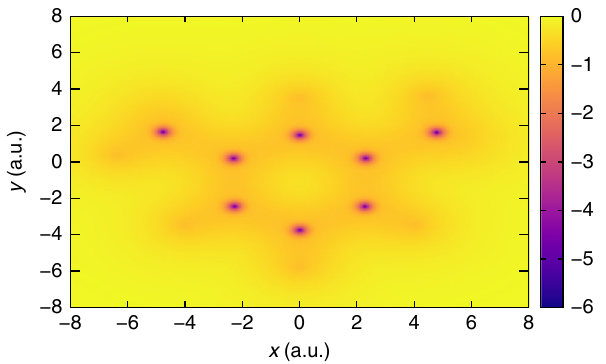
Fig. 3 Inverse DFT calculation on C 8 H 10 . The exchange-correlation potential (in a.u.) determined from the inverse DFT algorithm, using an LDA-based density, is displayed on the plane of the benzene ring. Refer to Supplementary Table 3 for the coordinates importantly, both the pro fi les are nearly identical, except for small differences in the bonding region between the H atoms. Further, a comparison of both these v s against the LDA-based xc potential xc ( v LDA ) elucidates the signi fi cant difference between the exact v xc